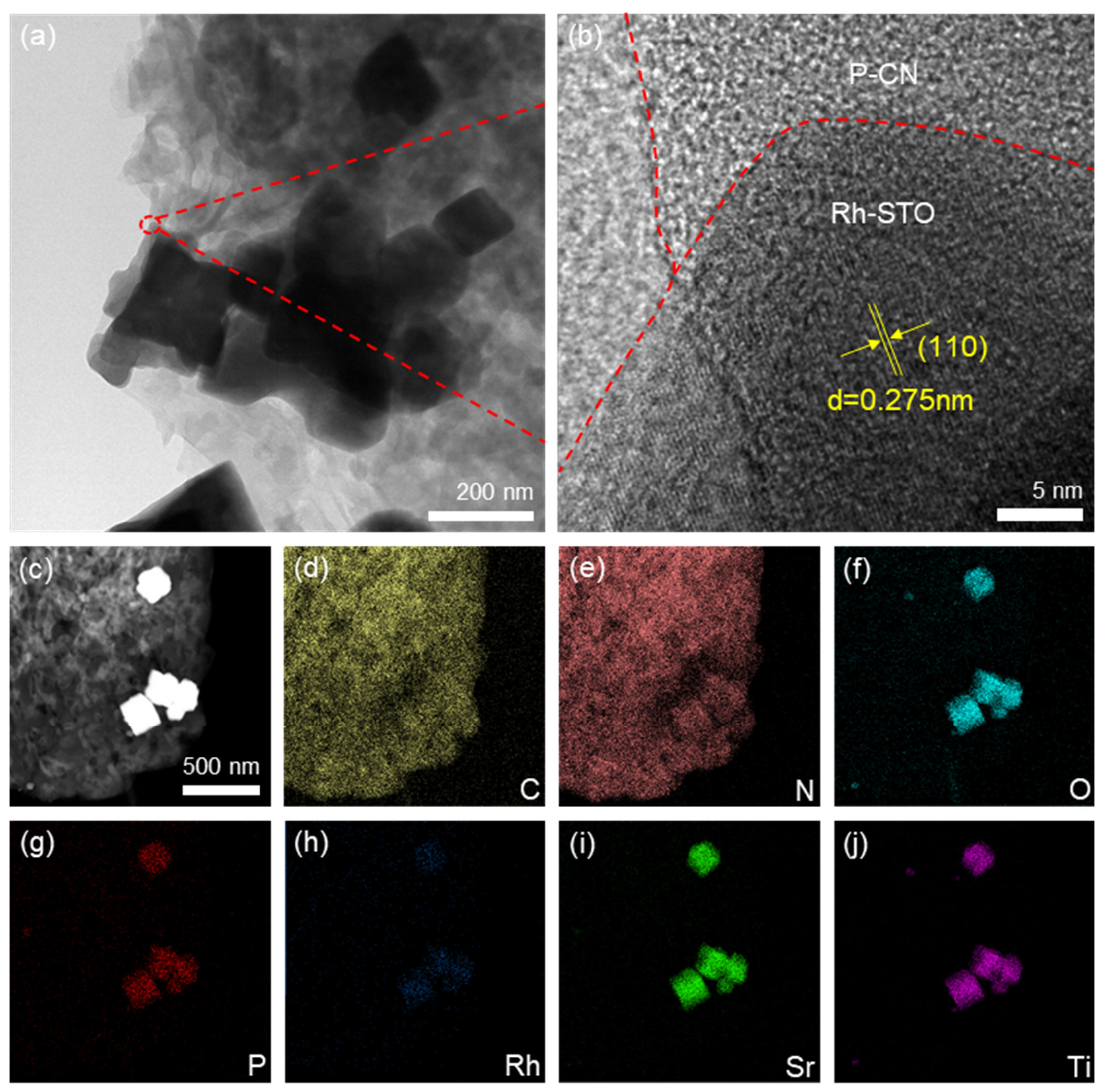
Figure 2. ( a ) TEM image, ( b ) HRTEM image, and ( c ) HAADF-STEM image of P-CN/Rh-STO-20; ( d – j ) the C, N, O, P, Rh, Sr, and Ti element mapping of P-CN/Rh-STO-20, respectively. ( d – j ) the C, N, O, P, Rh, Sr, and Ti element mapping of P-CN/Rh-STO-20,